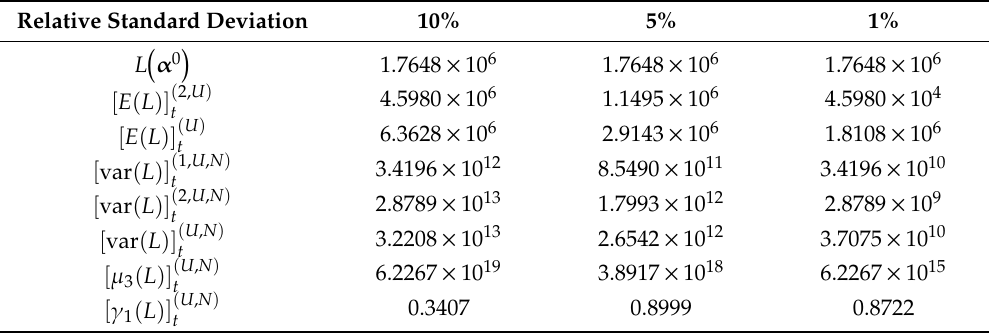
Table 25. Response moments for various relative standard deviations of total microscopic cross sections that are uncorrelated.